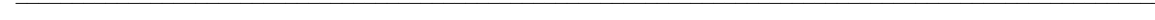
Fig. 6. Discrete micromeric elements of the ‘progressive type’ in some species of Psammosteus and their microstructure. A – E , PM SPU 80-5, Psammosteus ramosus sp. nov. Glinskiy, discrete tessera, Andoma Hill, Russia; А , lateral, B, posterior, C, top and D, visceral views, E, vertical section. F , PM SPU 80-9, Psammosteus cf. ramosus sp. nov. Glinskiy, fragment of discrete tessera – aspidin mound without surmounted dentine tissue, lateral view, Andoma Hill (outcrop N-2, layer AG 1-2), Russia. G , H , PM SPU 80-7, Psammosteus ramosus sp. nov. Glinskiy, fragment of discrete tessera, Andoma Hill, Russia; G, lateral and H, top views. I – M , PM SPU 75-11, Psammosteus cf. kiaeri Halstead Tarlo, 1964, discrete single element, Andoma Hill (outcrop OK-3, layer 5), Russia (Upper Devonian, Frasnian, P ļ avi ņ as RS); I, lateral, J, anterior, K, top and L, visceral views, M, vertical section. N – Q , PM SPU 75-10, Psammosteus falcatus Obruchev in Gross, 1942, fragment of discrete tessera, Lovat  River (outcrop 140, layer 6), Russia (Upper Devonian, Frasnian, Snezha RS); N, lateral, O, anterior and P, top views, Q, vertical section. F–H, SEM BSE images; A–E, I–Q, MicroCT images. Abbreviations: a.t., aspidin trabeculae; b.p., basal pore; p.c., pulp cavity; p.t., primordial tubercle; s.t., satellite